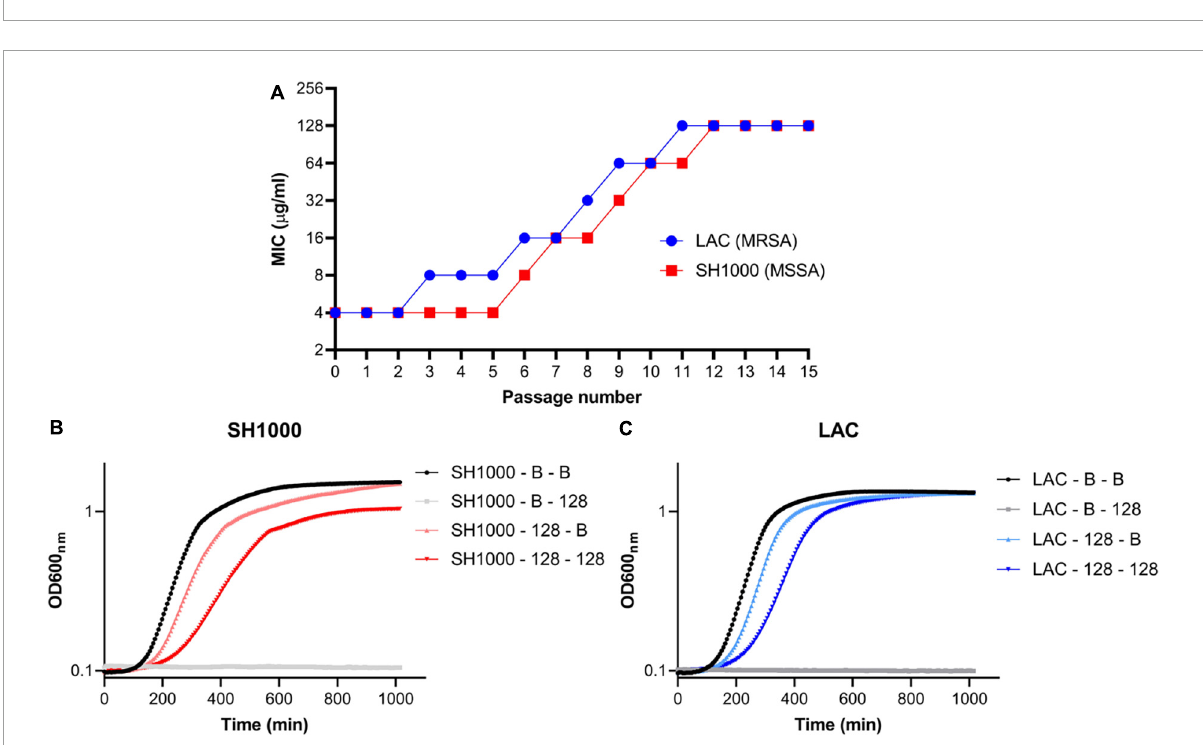
FIGURE4 Stable AHA-1394 resistant mutants emerge following AHA-1394 serial passage. (A) Increase of MIC following passage every 24 h of LAC (blue) and SH1000 (red). Bacterial growth curves of (B) SH1000-B and SH1000-128 and (C) LAC-B and LAC-128 grown in MHB (SH1000-B-B; SH1000-128-B; LAC-B-B; LAC-128-B) or MHB containing AHA-1394 (128 µ g/ml) (SH1000-B-128; SH1000-128-128; LAC-B-128; LAC-128-128). OD600 nm was plotted against time following 18 h incubation. The dots represent the mean of three biological